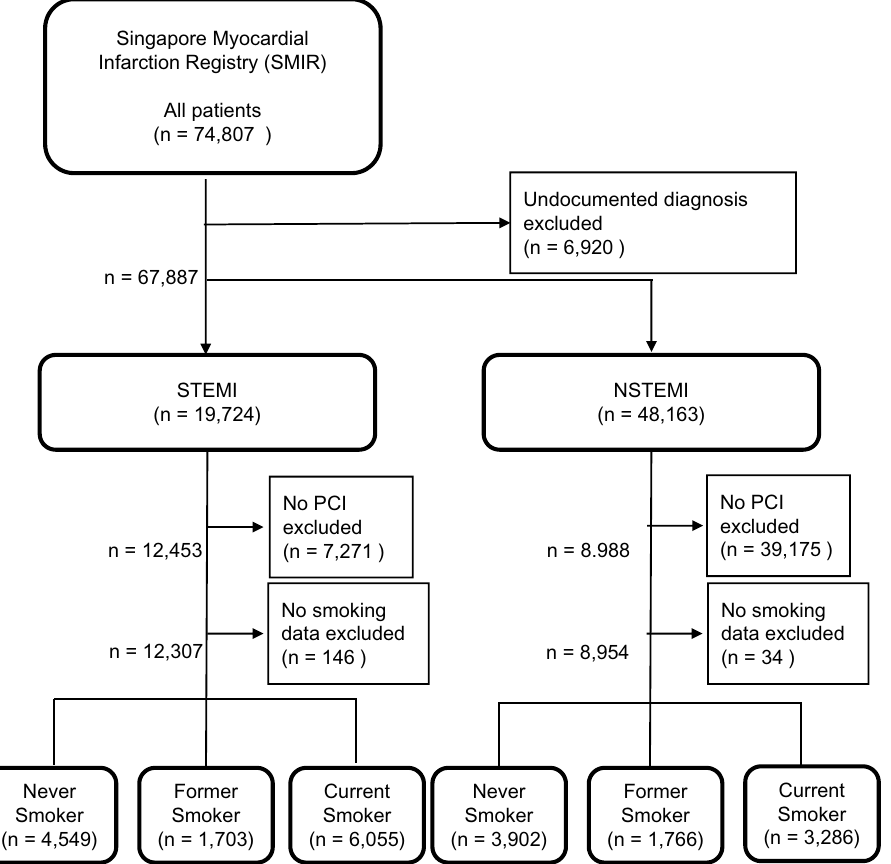
Figure 1. Flowchart of data inclusion. 74,807 patients were registered in the Singapore Myocardial Infarction Registry (SMIR). 6920 patients were excluded from the data analysis as the type of their acute coronary syndrome (ACS) was unclear. This exclusion left only ST elevation myocardial infarction (STEMI) and Non- STEMI (NSTEMI) in the dataset. Those who did not undergo percutaneous coronary intervention (PCI) or did not have smoking data were excluded from the data analysis. The patients were then further divided into the details of their smoking